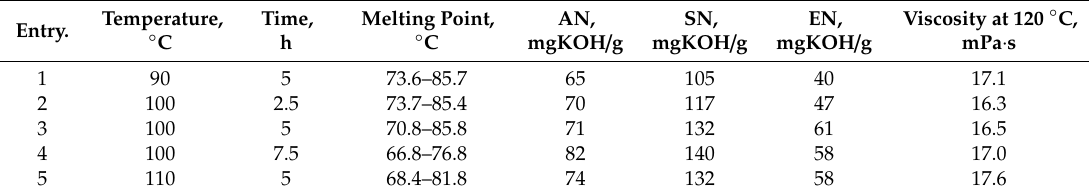
Table 7. E ff ect of temperature and reaction time on the oxidation of the pre-oxidized raw material using oxygen.